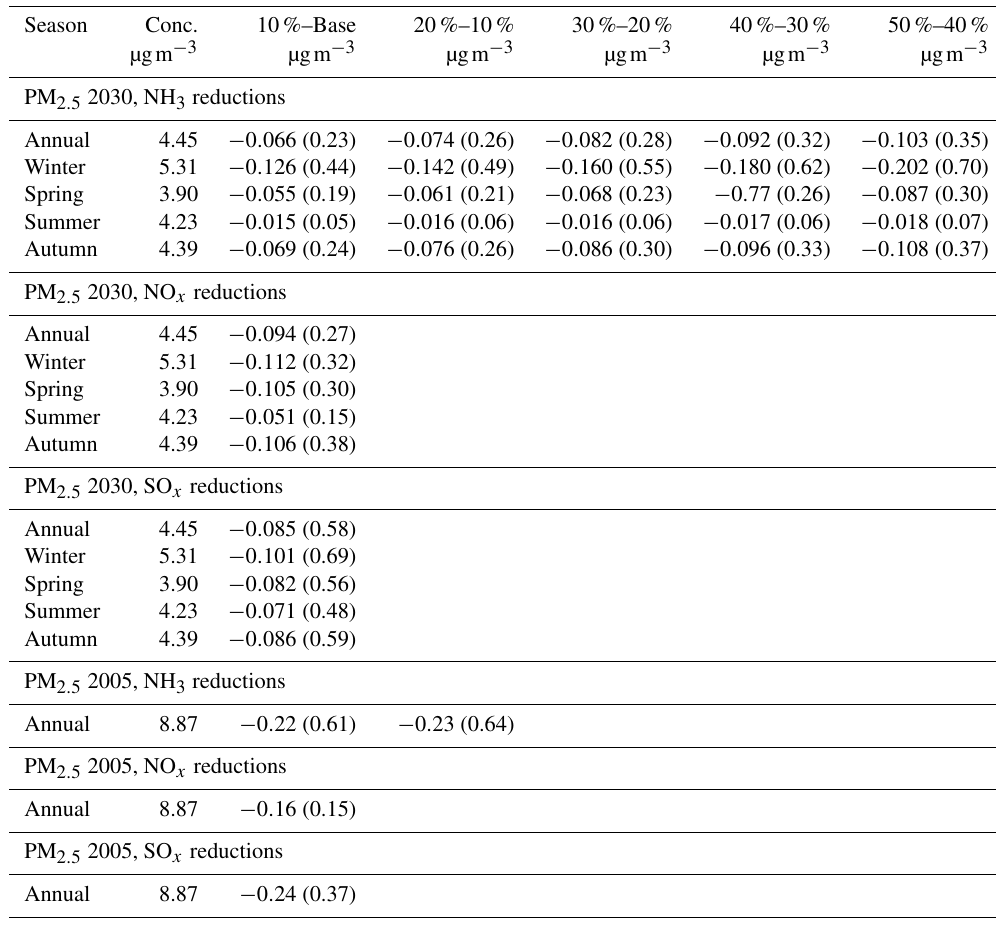
Table 4. First column listing annual and seasonal concentrations of PM 2 . 5 as an average for the EU28 countries. Columns 2–5 list the EU28 average reductions calculated in steps of 10% reductions in NH 3 emissions. For PM 2 . 5 the reductions in ngNm − 3 per gigagram of reduction of NH 3 emissions are shown in brackets. The corresponding effects of 10 and 20% reductions of NH 3 emissions in 2005 are also shown. The effects of 10% reductions of SO x and NO x emissions in 2030 are also listed. The reductions in PM 2 . 5 in ngNm − 3 per gigagram emitted are given in brackets with NH 3 counted as NH 3 with molecular weight 17, NO x counted as NO 2 with molecular weight 46, and SO x counted as SO 2 with molecular weight